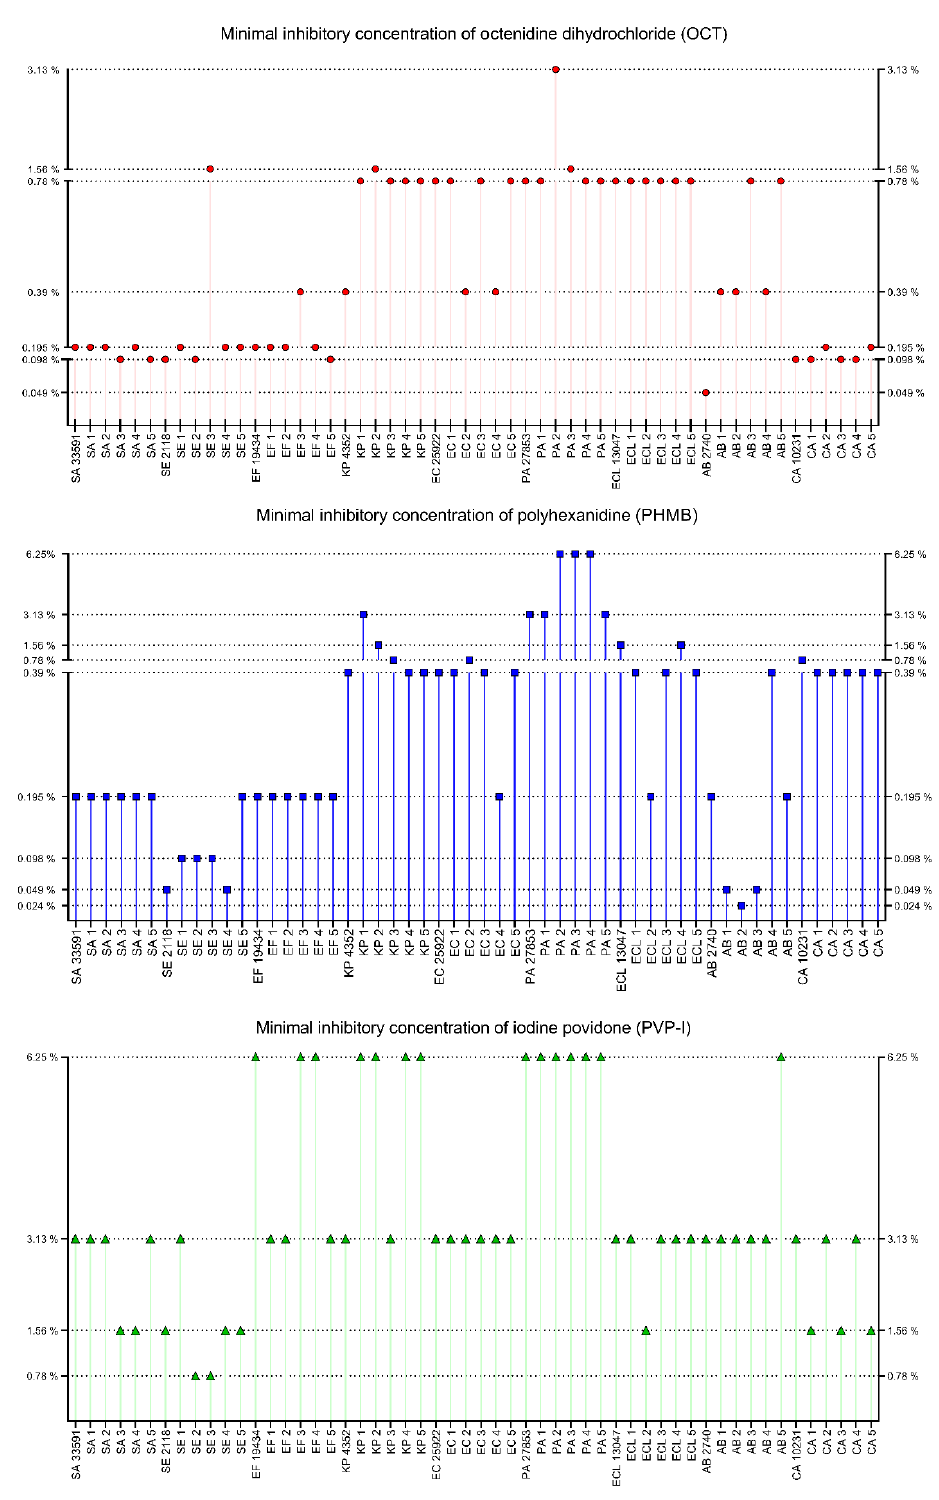
Figure 5. Minimal inhibitory concentrations of OCT, PHMB and PVP-I, presented as a percentage of working solutions (concentration provided by the manufacturer). Tested compounds: OCT — octenidine dihydrochloride, PHMB — polyhexanide, PVP-I — povidone-iodine (Octenilin ® 0.05% of OCT, Prontosan ® 0.1% of PHMB and Braunol ® 7.5% of PVP-I). Tested strains: SA — Staphylococcus aureus , SE—